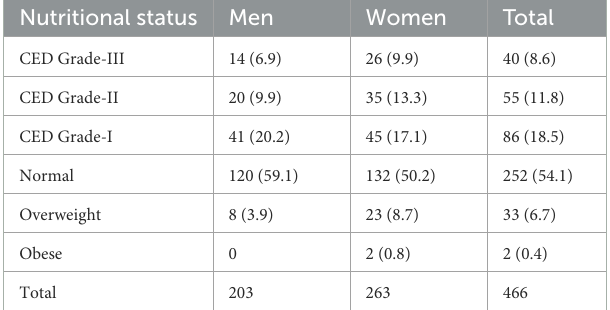
TABLE 3 Nutritional status based on BMI (WHO., 1995) of adult Oraons of West Bengal. Nutritional